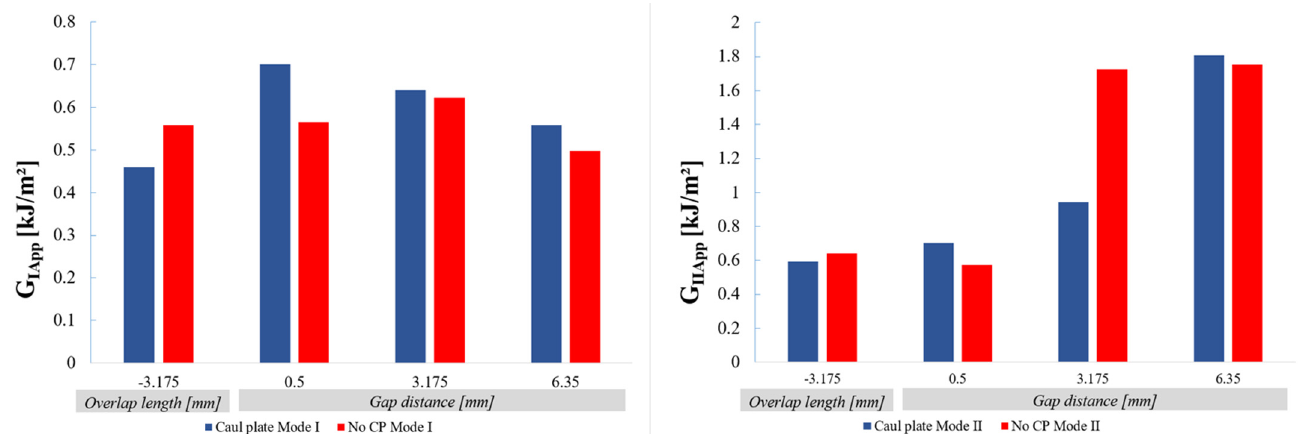
Figure 19. Influence of the caul plate on Mode I ( left ) and Mode II ( right ) fracture